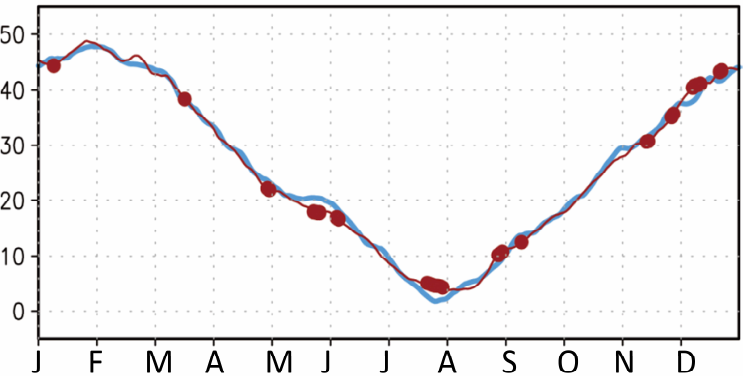
Figure 12. Averaged zonal winds (m s −1 ) within 200–500 hPa in the region, 110° E–140° E, 25° N–40° N, for the AA (red line) and IP0 (blue line) simulations. Large dots indicate that the differences between AA and IP0 have a confidence level of 90%.